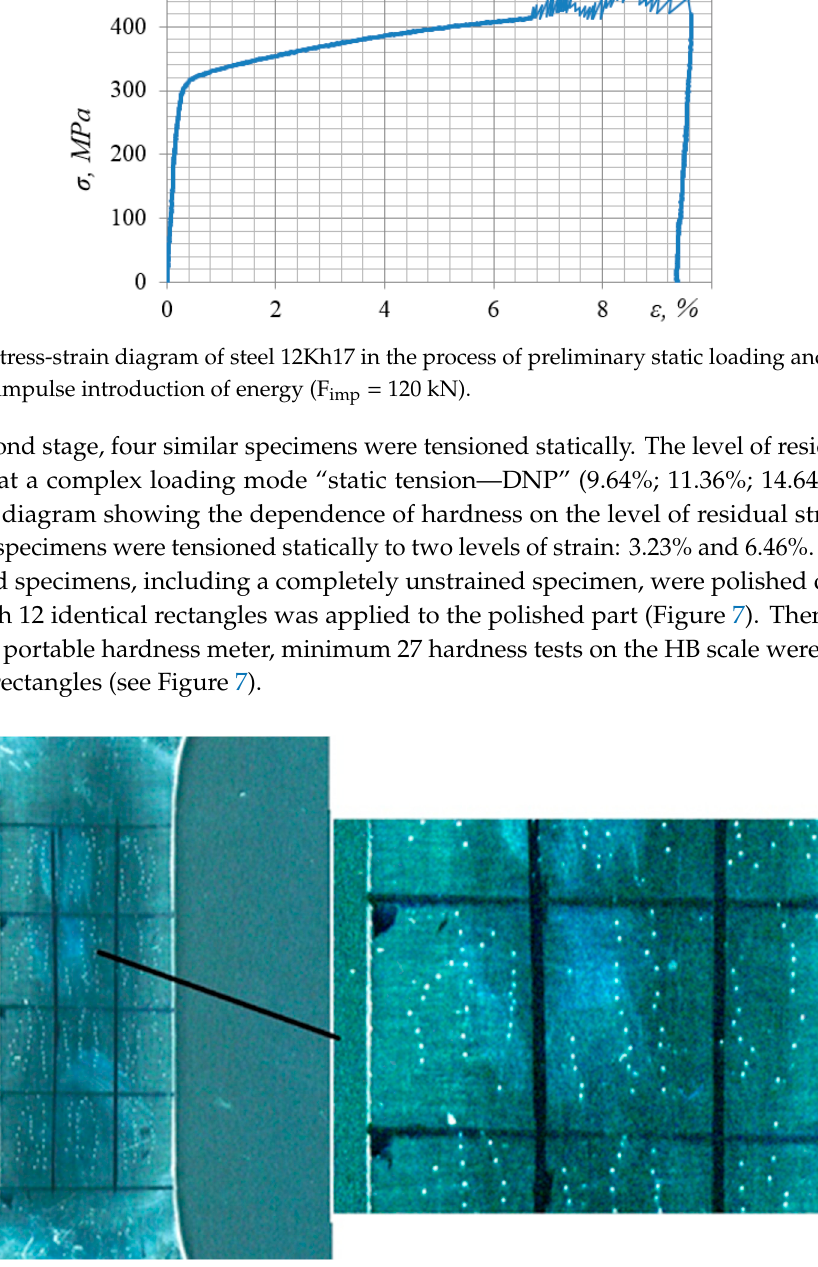
Figure 7. Grid applied to the specimen for hardness measurement and the location of inclusions.